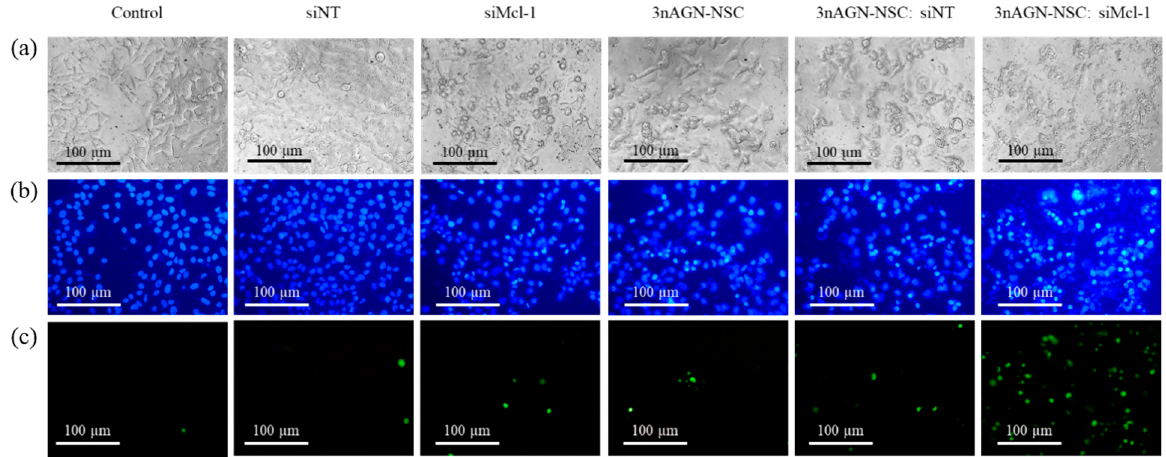
Figure 7. Double-stain apoptosis detection was observed under an inverted fluorescence microscope (100X) after incubation with 3nAGN (10.71 µM), siMcl-1 (0.075 µM), siNT (0.075 µM), 3nAGN-NSC:siNT (10.71 and 0.075 µM), or 3nAGN-NSC:siMcl-1 (10.71 and 0.075 µM) for 24 h; ( a ) bright field images, ( b ) fluorescence images of Hoechst 33342 staining (blue fluorescent cells), ( c ) fluorescence images of SYTOX™ Green staining (green fluorescent cells).